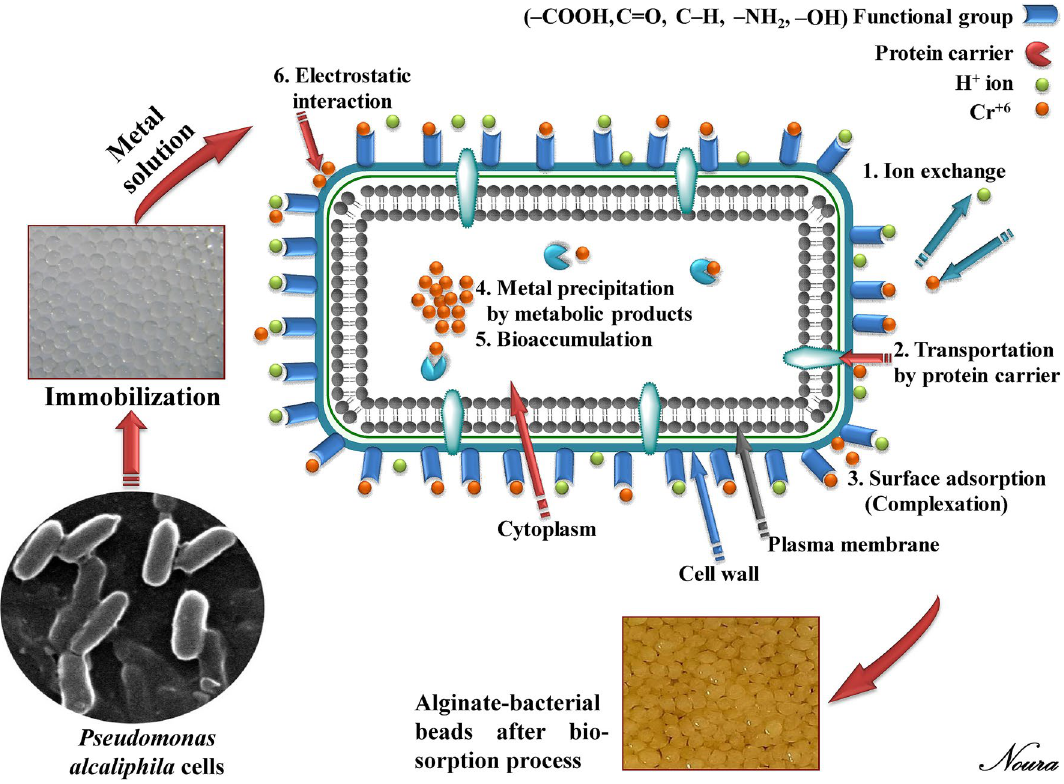
Figure 6. Schematic diagram showing the possible kinetic mechanisms of metal ions biosorption by the bacterial cell. The photograph was taken by using scanning electron microscope for P. alcaliphila NEWG-2